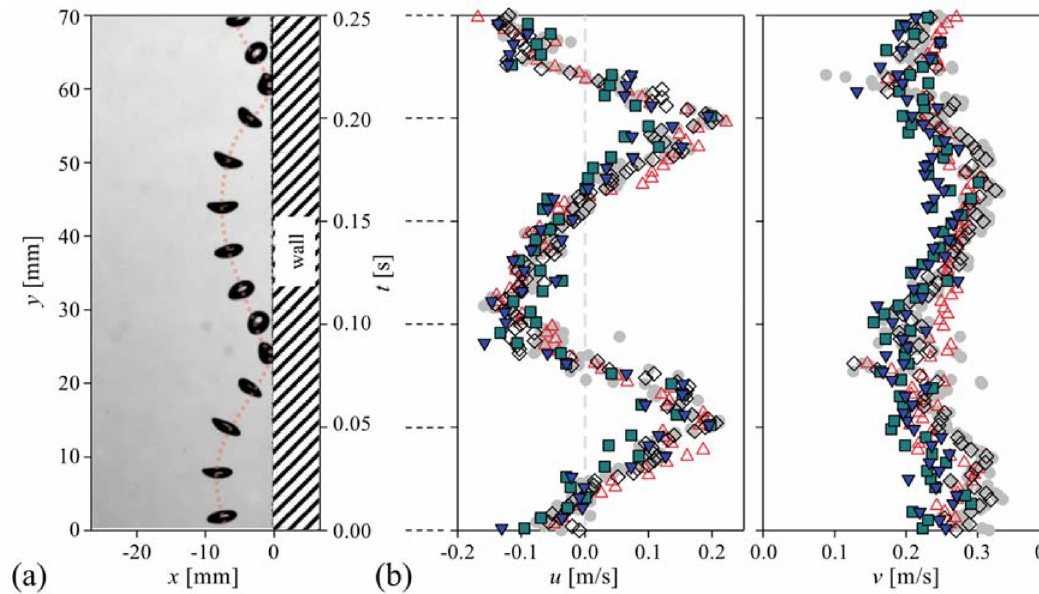
Figure 6. Evaluation of the velocity of a single bubble rising (with bouncing) near the wall: ( a ) sequential bubble shadow images with the time interval of 20 ms. The dotted line denotes the bubble trajectory. ( b ) Corresponding time history of the horizontal ( u ) and vertical ( v ) bubble velocities: filled circle, PTV; open triangle, Lukas-Kanade method; open diamond, Farnebäck method; filled square, pre-trained CNN-based model; inverted filled triangle, fine-tuned CNN-based